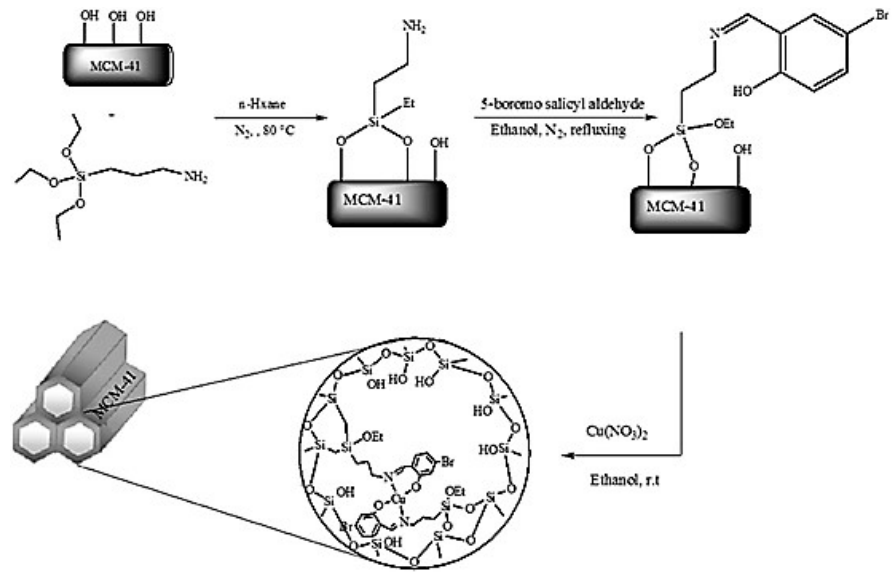
Figure 22. Synthesis steps of Cu-salen-MCM-41. Reproduced with permission from [30]. Copyright 2014 Springer.